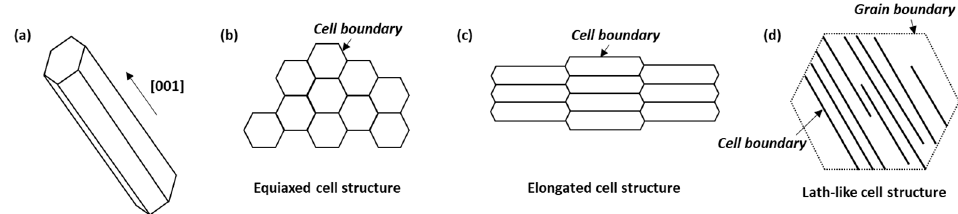
Figure 3. Schematic illustrations of ( a ) cell growth direction and ( b – d ) cellular structure types according to morphology.